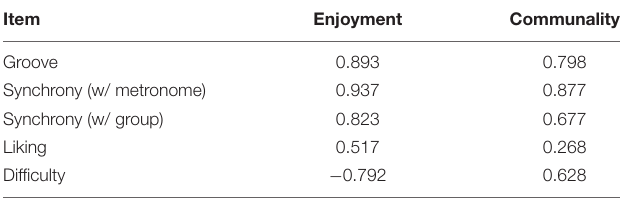
TABLE 3 | Item loadings for the Enjoyment factor (Exp.